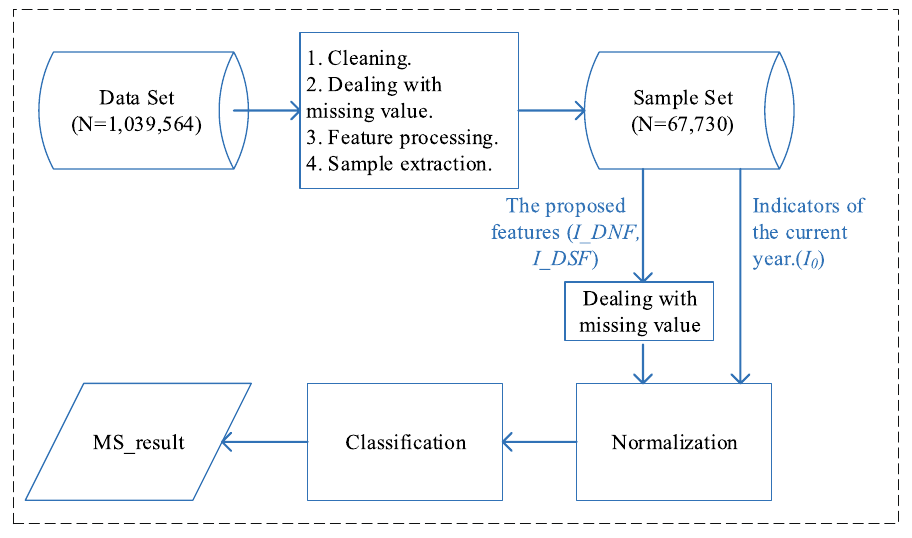
Figure 4. Framework of our MetS risk predictive